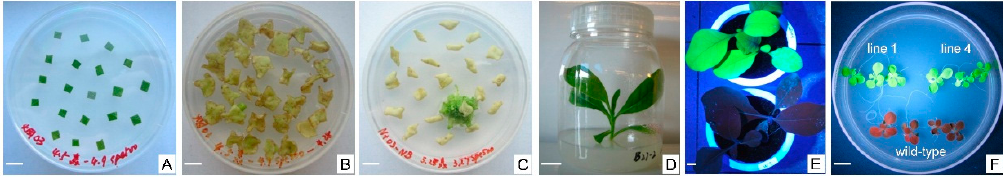
Figure 2. Procedure for homoplastomic selection after chloroplast transformation of tobacco. ( A ) Bombarded leaves were cut into pieces for selection; ( B ) Resistant shoots appear while most leave pieces bleached on antibiotic medium; ( C ) Surviving antibiotic resistant shoots; ( D ) Regenerated plantlet after first round of selection; ( E ) GFP expression in T 0 transplastomic tobacco with green color and chlorophyll autofluorescence with red color under ultraviolet (UV) lamp; ( F ) GFP expression in T 3 homoplastomic tobacco seedlings, line 1 and line 4, and wild-type control under UV lamp. Scale bars = 1 cm.